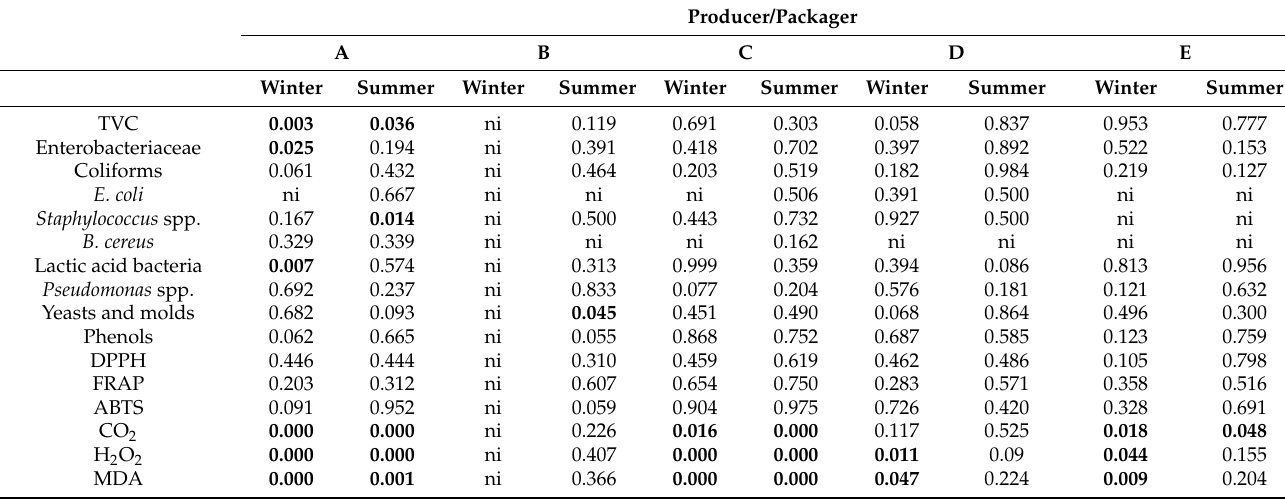
Table 3. Effect of shelf life, salad producer/packager and type on microbiological load (log cfu/g), total phenolic content (mg GAE/g Fw), antioxidants (mg Trolox/g Fw) and% CO 2 and stress markers—H 2 O 2 ( µ mol/g Fw) and MDA (nmol/g Fw) of ready-to-eat salads according to salad producer in winter and